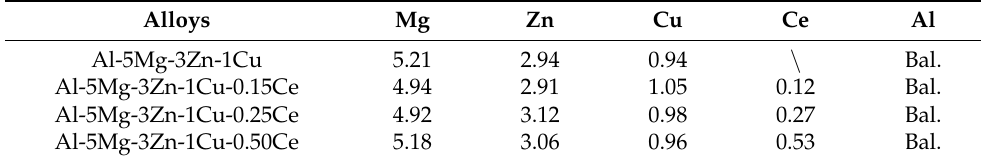
Table 2. Chemical composition of cast Al-Mg-Zn-Cu-xCe alloys